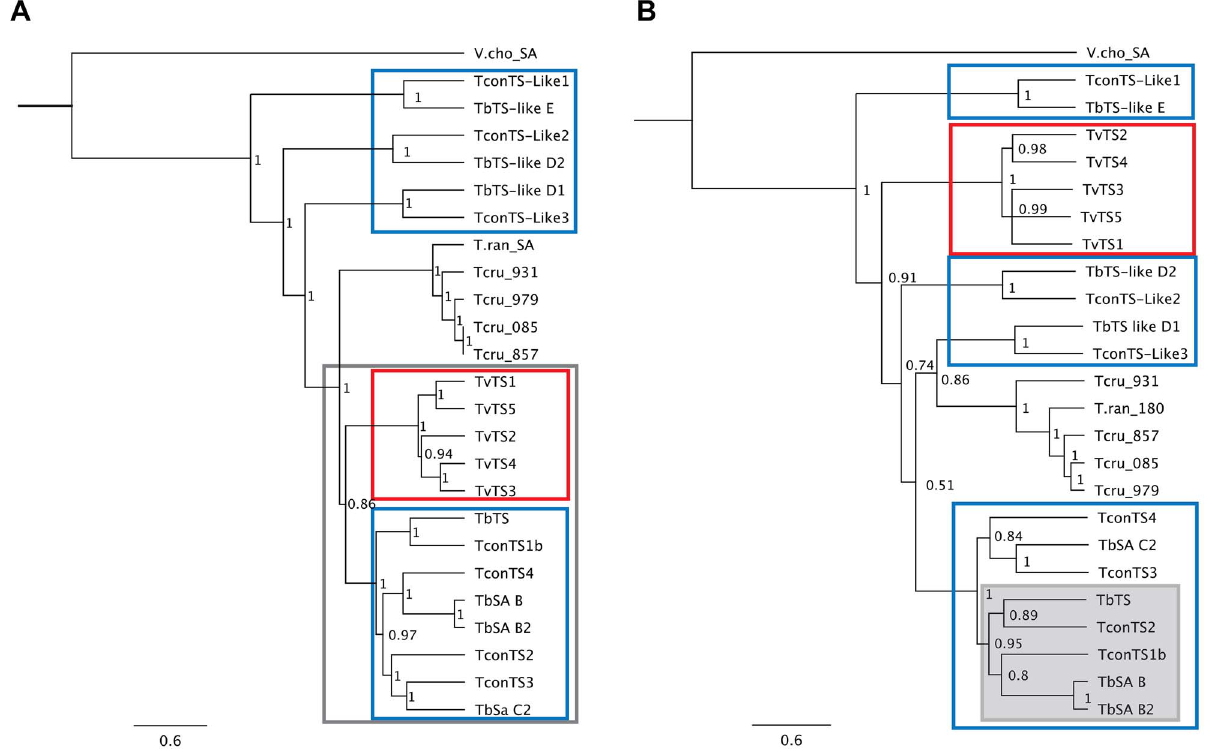
Figure 2. Phylogenetic analysis TS genes. Phylogenetic analyses of DNA sequences were performed as described under Methods using ‘‘MrBayes’’ plug-in of Geneious. Trees are midpoint rooted and nodes supported by posterior probability values and non-parametric bootstraps generated by maximum likelihood analysis in ‘‘MrBayes’’ as described under Methods. TS genes from T. congolense and T. brucei are marked by blue frames, TS genes from T. vivax by red frames. A : Phylogenetic tree for full ORFs, the ‘‘African TS-branch’’ is marked by a grey frame; B : Phylogenetic tree for LDs, the most active TconTS and their orthologues from T. brucei are highlighted by a grey box. doi:10.1371/journal.pntd.0002549.g002 PLOS Neglected Tropical Diseases |